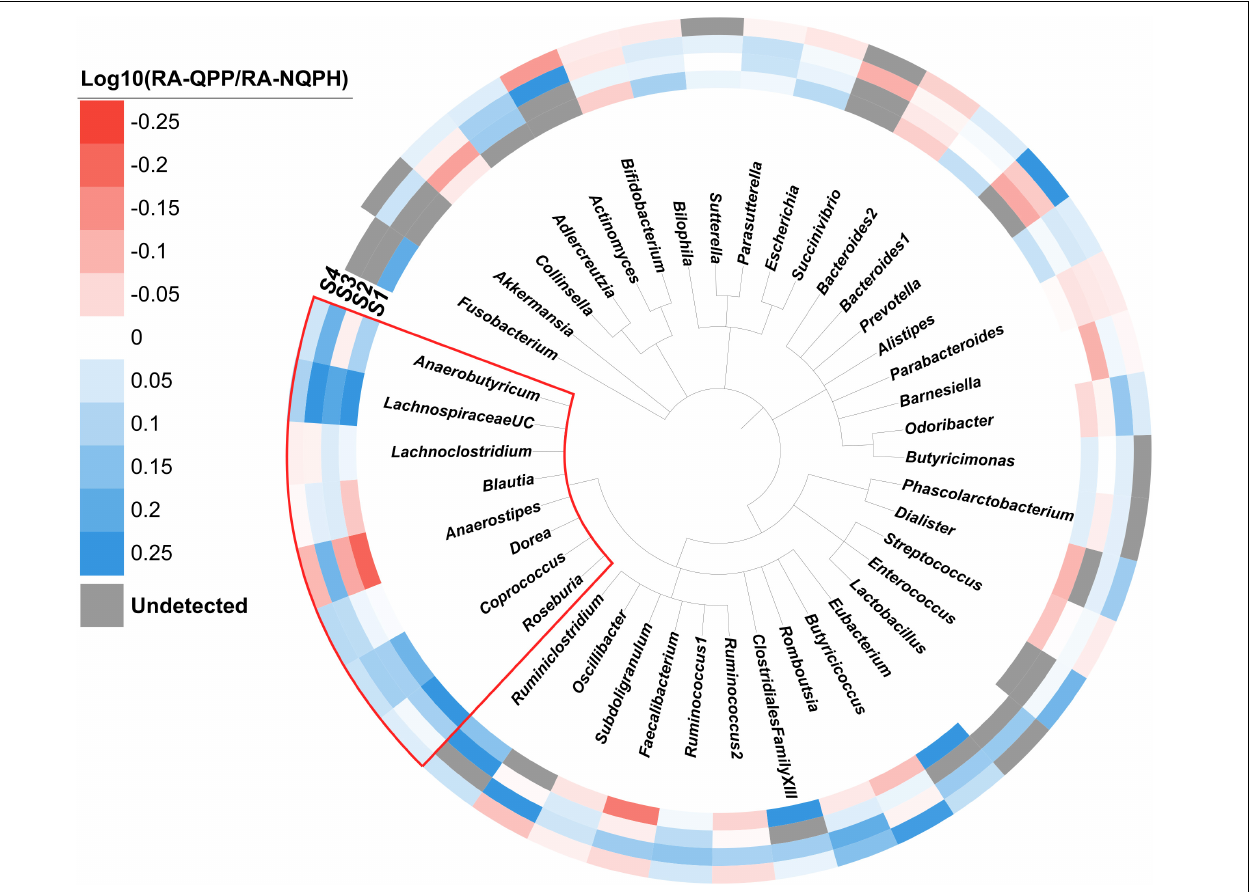
FIGURE 2 | Phylogeny of the genera observed in the four subjects. The colored ring denotes the log ratio of the relative abundance of each genus in microbiomes treated with QPP to NQPH. Gray bars indicate the genus was not present at a detectable level. The red box indicates members of the Lachnospiraceae